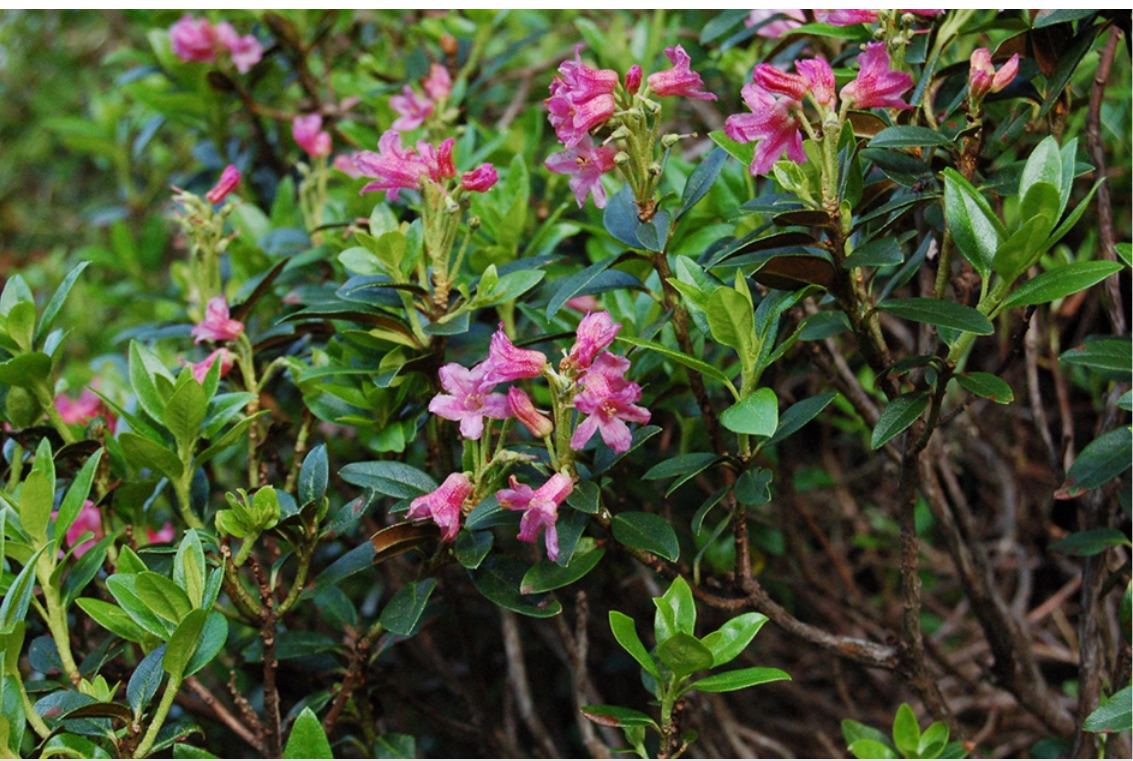
Fig. 3 An individual of Rhododendron ferrugineum growing at the studied